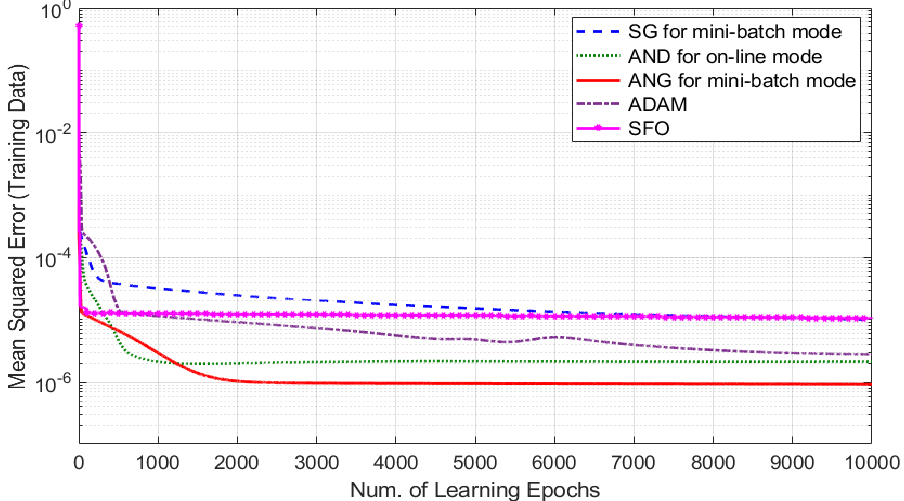
Figure 2. Change of prediction errors for Mackey-Glass series depending on the number of epochs.